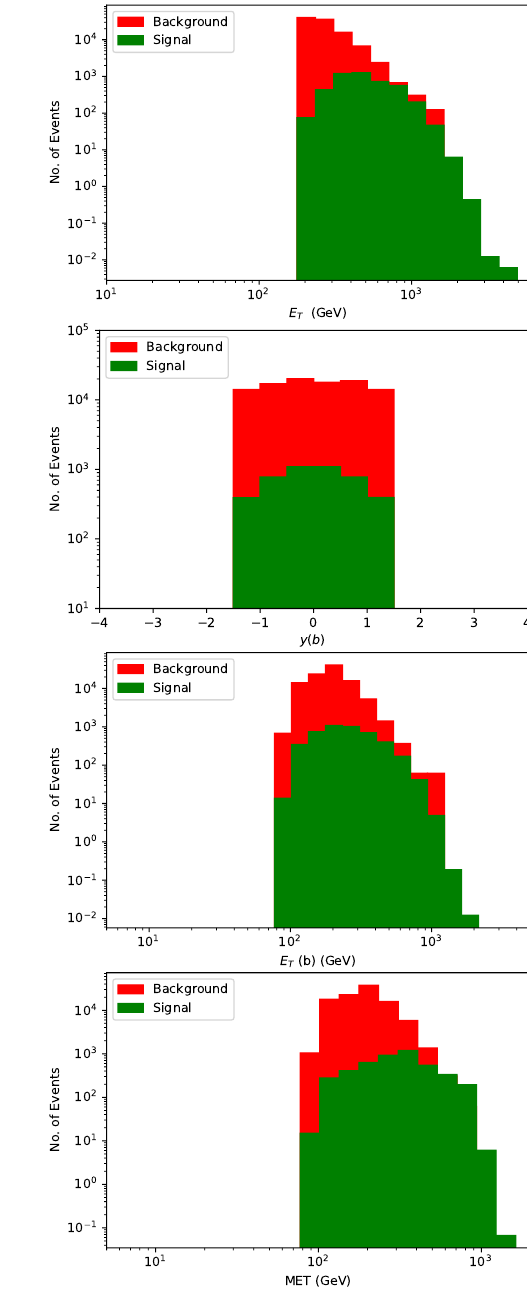
Figure 5 . Parton level event distributions for pp → ¯ q 0 q 0 → ¯ bbH 0 an integrated luminosity of 300 fb − 1 along with the SM background (in red), here q 0 represents all the exotic quarks i.e., d 0 , s 0 , b 0 . (Left column, top to bottom): the total transverse energy E T , the rapidity y , the total transverse energy of the b quark, E T ( b ) , and the missing transverse energy /E before cuts. (Right column, top to bottom): the same distributions after implementing the cuts in table 11, which reduce the